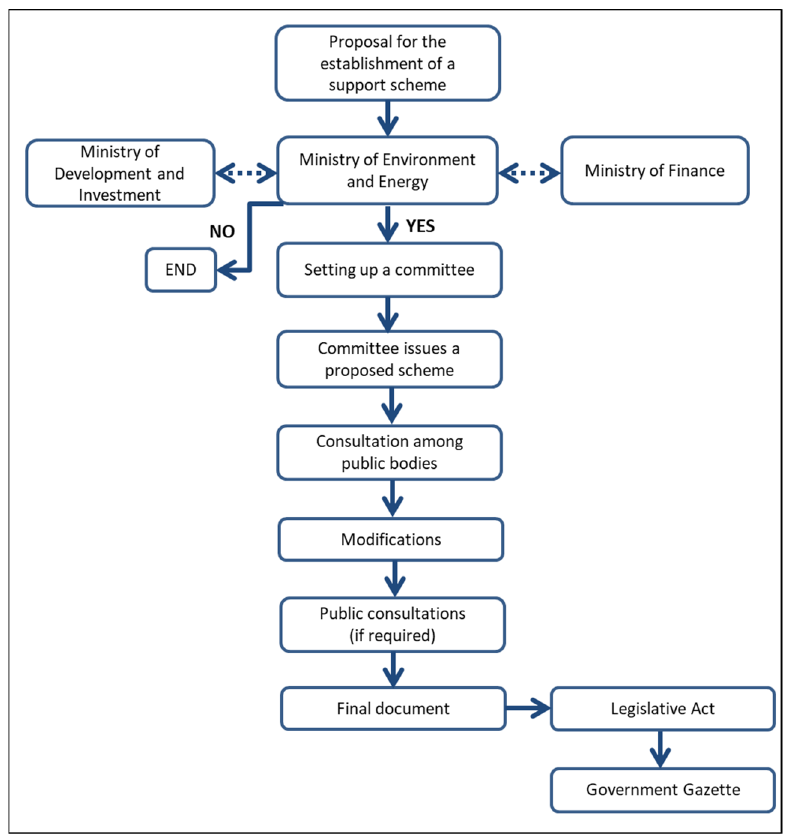
Figure 5. Mapping of the decision-making process in Greece, referring to the establishment of an energy-related support scheme (own creation).